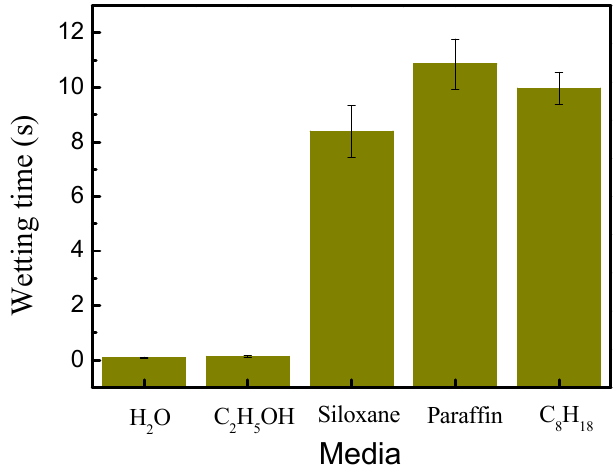
Figure 6. Influence of non-aqueous media on the adsorption of the aqueous solution.